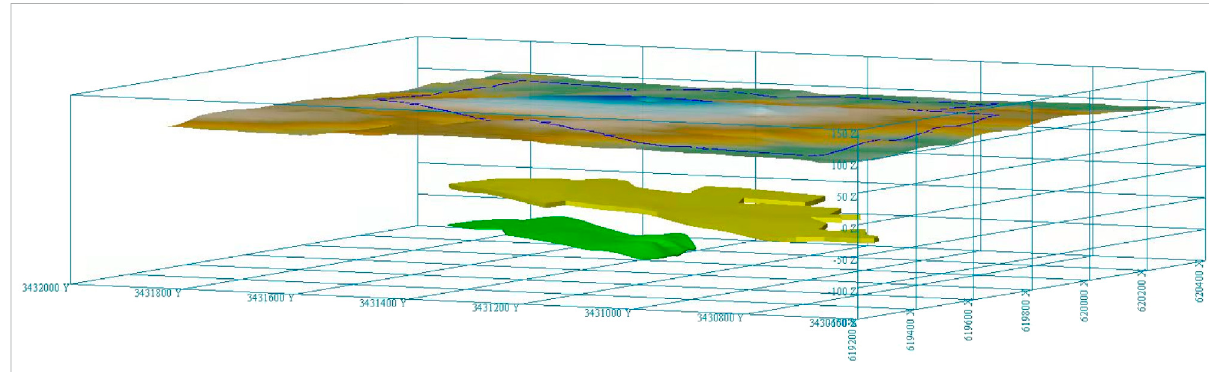
FIGURE 3 Spatial distribution diagram of Rongxing gypsum mine surface (top), X gypsum goaf (middle), VI gypsum goaf (bottom).